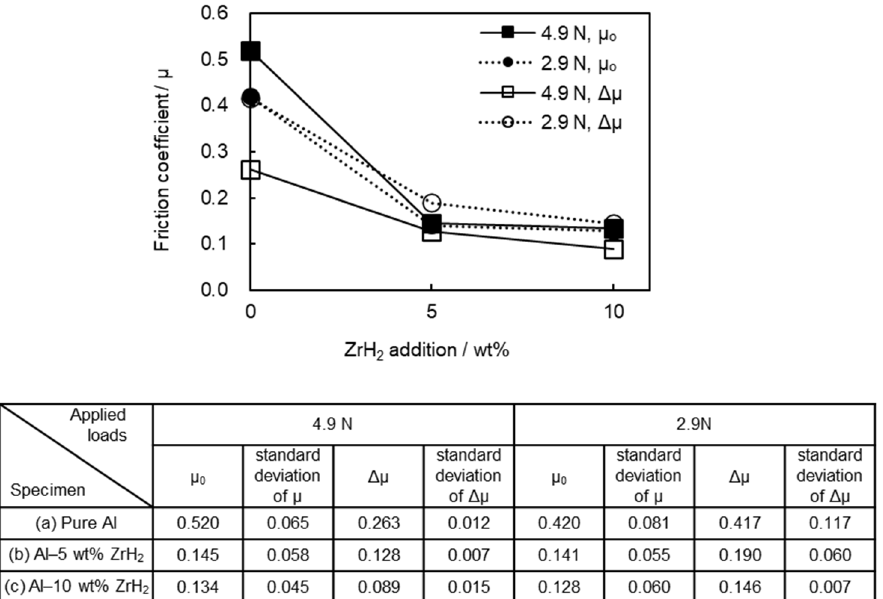
Figure 6. Changes in the friction coefficient averaged over three measurements for pure Al, –5, and –10 wt% ZrH 2 under applied loads of 2.9 and 4.9 N. The table lists the mean friction coefficient ( μ 0 ) and its mean variation ( Δμ ), and their standard deviation for each pin specimens under applied loads of 2.9 and 4.9 N.